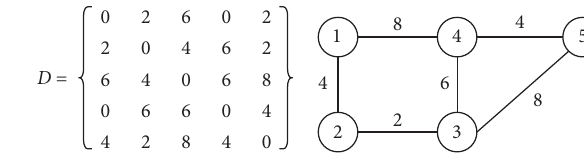
Figure 2: Illustrative example. Table 1: Dataset structure of the